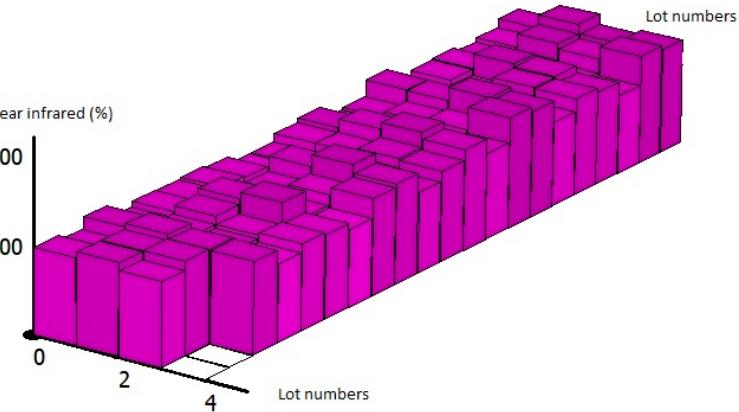
Figure 10. Distribution of the reflection parameters over elementary areas of the field with sowing of spring wheat in the “near infrared” region of the spectrum.